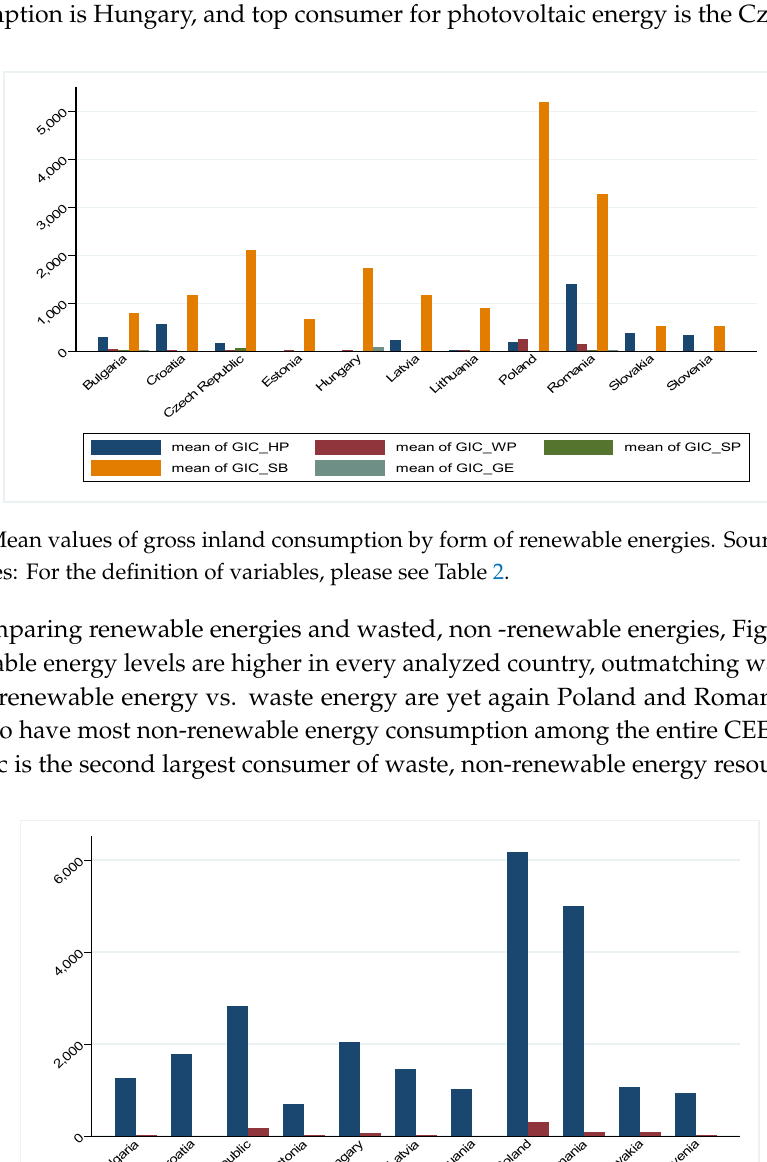
Figure 1. Mean values of renewable energy consumption (% of total final energy consumption).